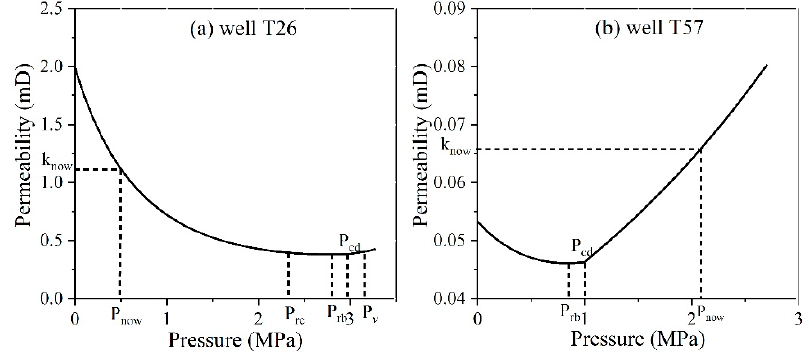
Figure 8. Dynamic characterization of reservoir permeability of the target wells. P now and k now are the current reservoir average pressure and corresponding reservoir permeability, respectively.